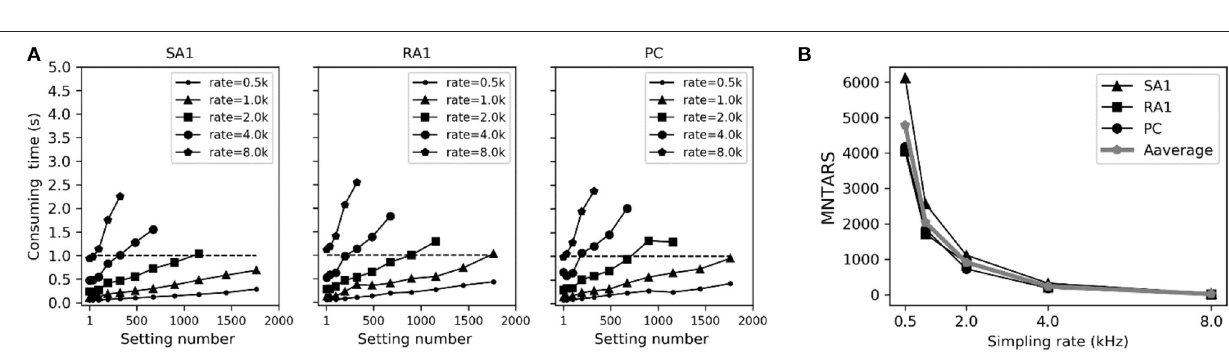
FIGURE 7 | Evaluation of computation efficiency for simulating population units. (A) Averaged consuming time for simulating each type of tactile unit for 1 second at different setting number under different sampling rate. Error bar represent the standard deviation of the mean. (B) MNTARSs at different sampling rates. The MNTARS was evaluated as the setting number at cross of consuming time curve and horizontal dotted line in panel (A)